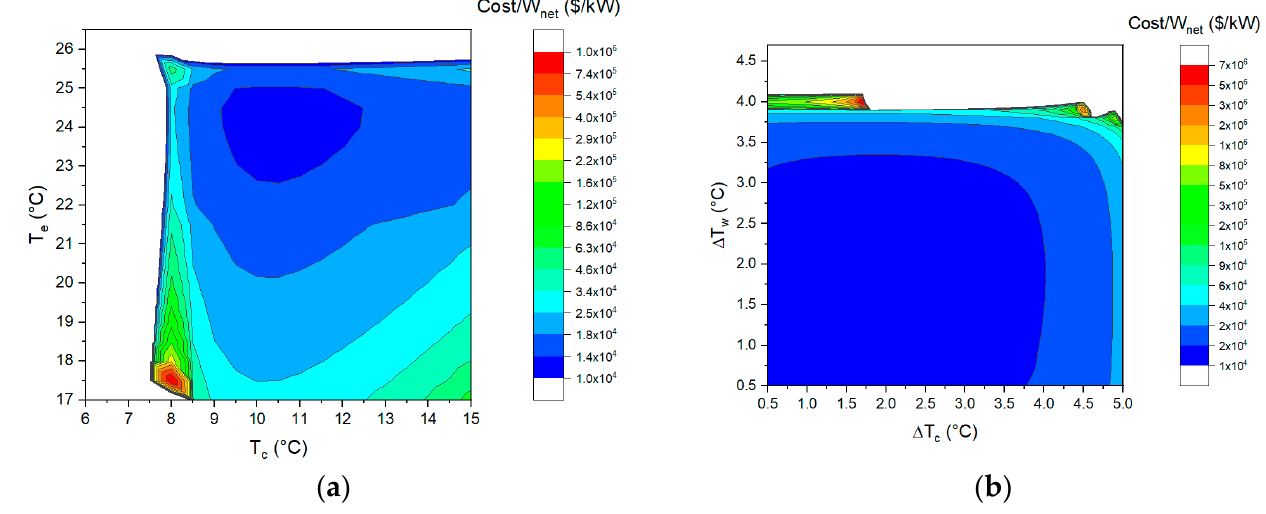
Figure 12. The effect of ( a ) the evaporating and condensing temperature and ( b ) pinch-point temperature differences on the investment cost per unit net output power.